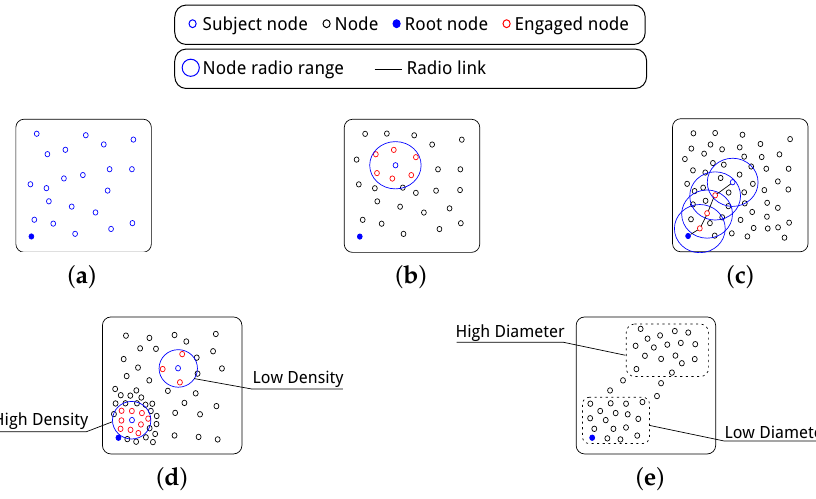
Figure 3. Illustration of the manifestation of the physical features in the network. ( a ) Size is 22: Total number of nodes that constitute the network; ( b ) Density, 6: The number of nodes within communication range; ( c ) Diameter, 4: Minimum number of hops necessary to reach the root; ( d ) Illustrating a high standard deviation in terms of network density. This scenario can occur when a number of highly sensed environments exist with sparsely sensed environments within the same network; ( e ) Illustrating a high standard deviation with regard to network scale. This occurs commonly within buildings when nodes in geographically spaced rooms exist on the same